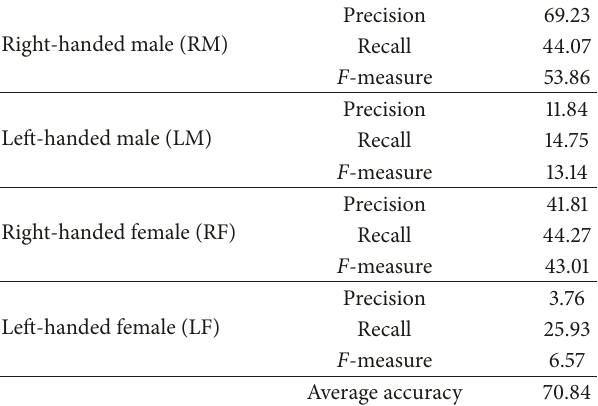
Table 8: Performance results for combined gender-and-handedness classification on KHATT